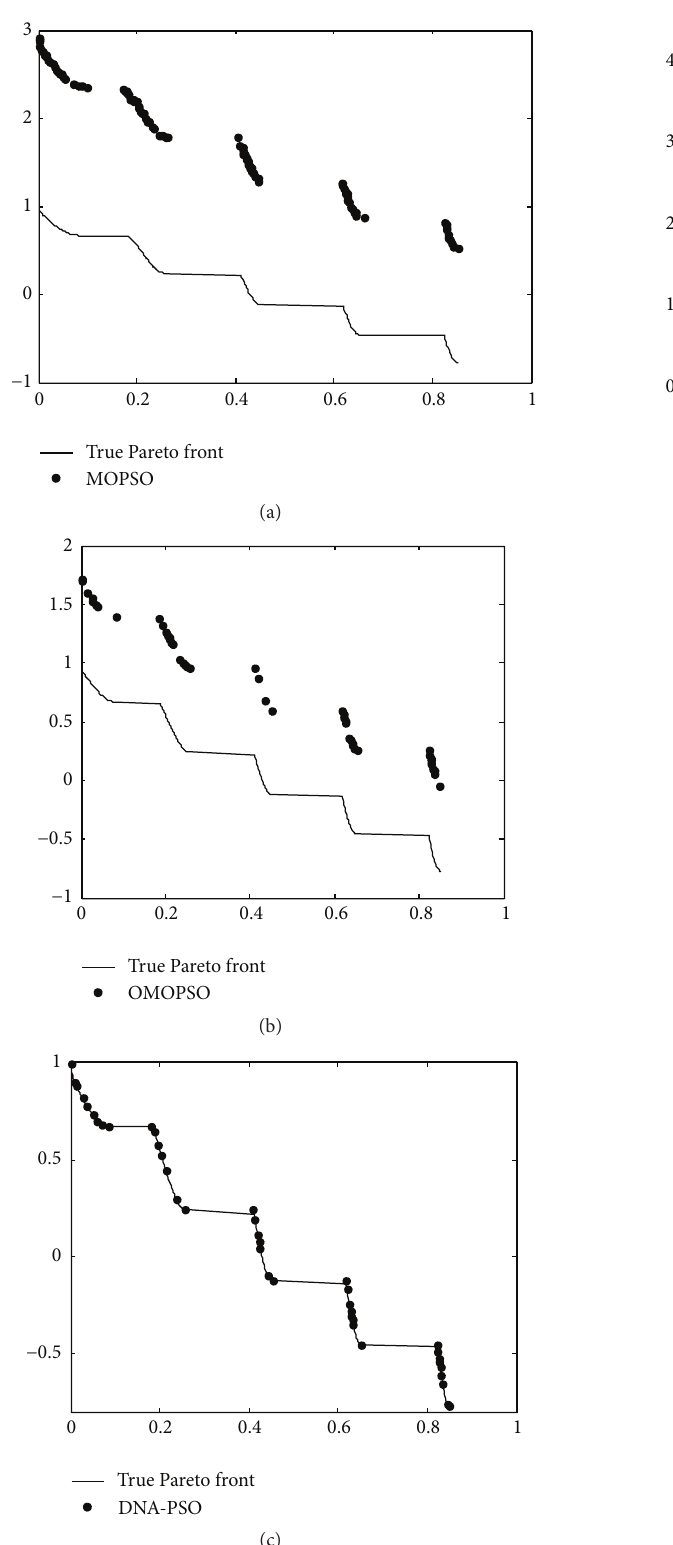
Figure 9: Pareto fronts obtained in test problem